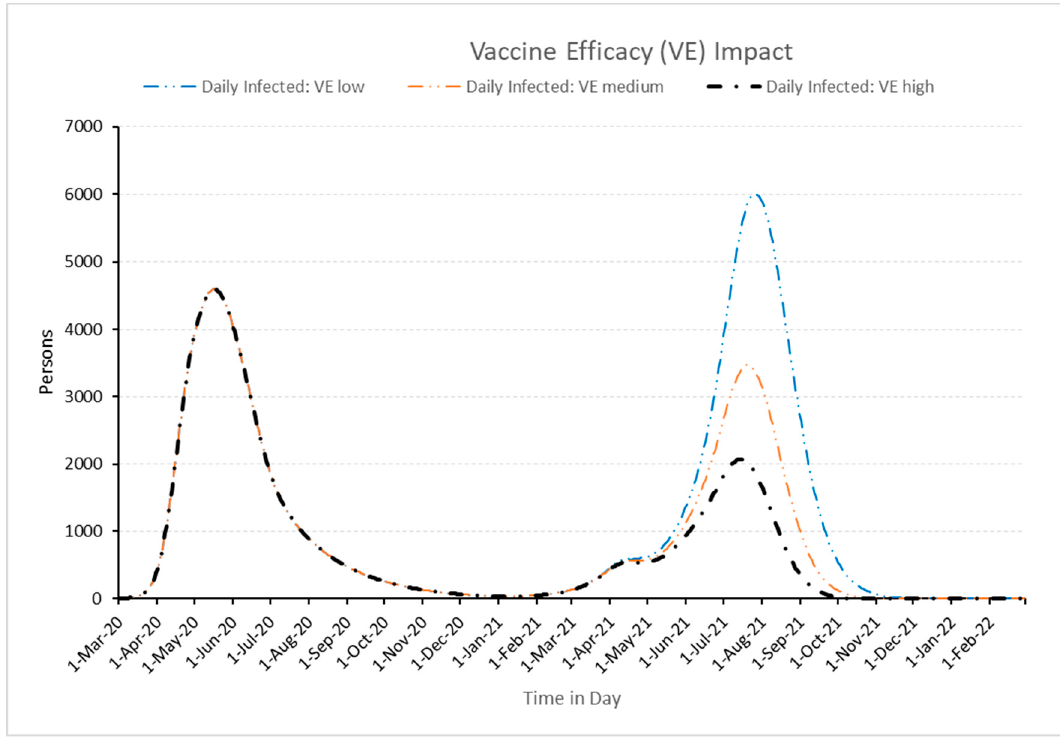
Figure 10. Impact of vaccine efficacy on daily infected people.